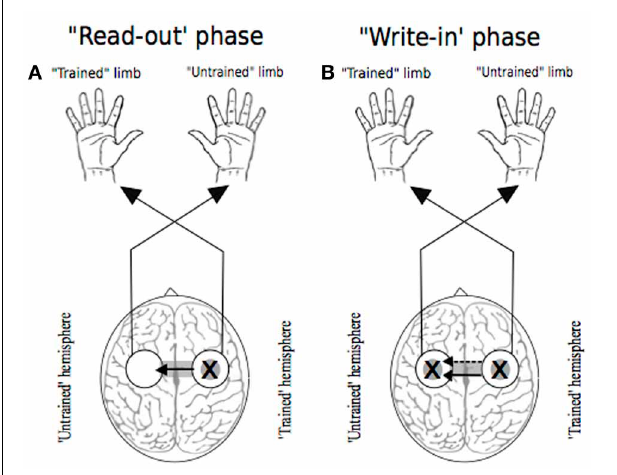
FIGURE 5 | Two phases of transfer. In each instance the “X” represents the putative locus of training related adaptations. White circles indicate lateralized motor networks in their entirety. Following Nadel and Buresova (1968), Panel (A) represents the ’read-out’ phase (solid arrow) whereby training related adaptations in motor networks projecting to the training limb are accessible during movements made subsequentlyby the untrained limb. Panel (B) depicts the possibility that, during the course of such access (i.e., “read out”), a “write-in” phase (dashed arrow) occurs, whereby a parallel duplicate motor engram is